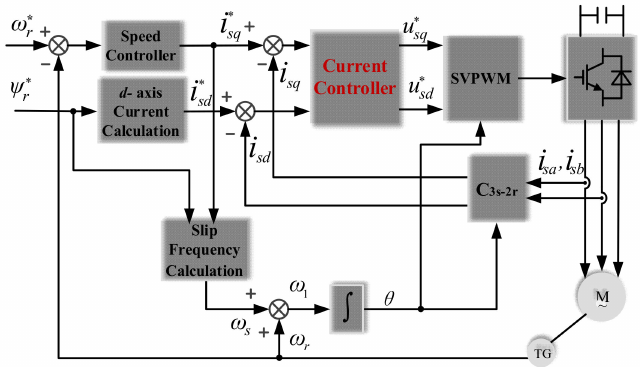
Figure 1. Control block diagram of Flux Oriented Control